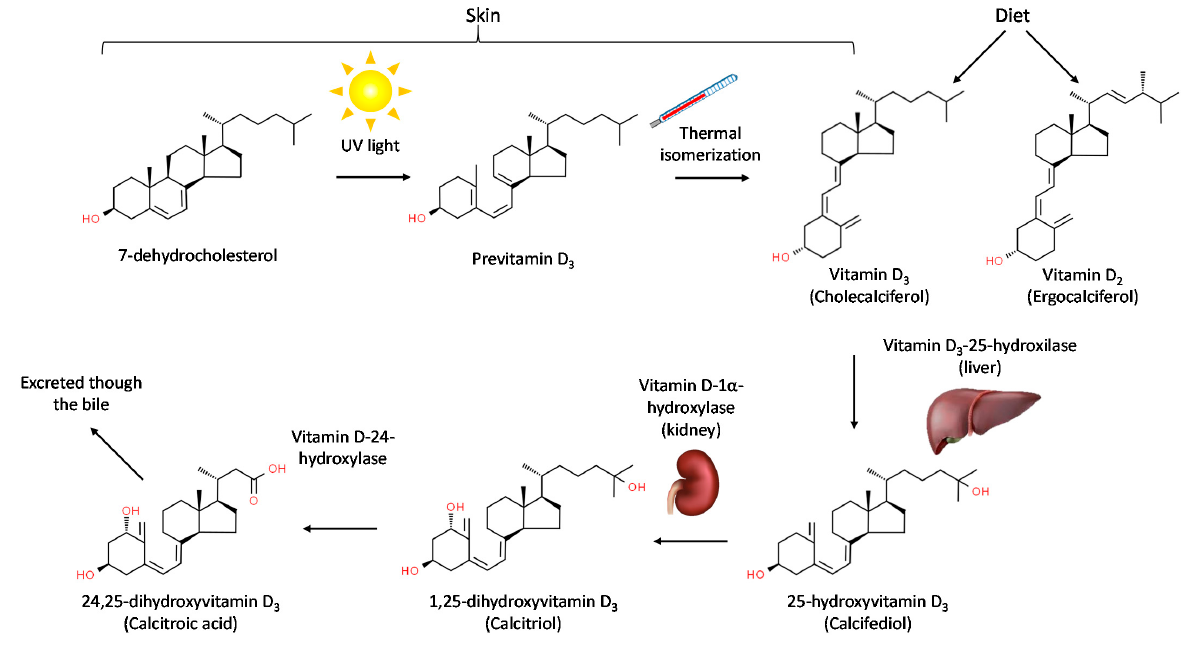
Figure 1. Metabolism of vitamin D. Vitamin D exerts its function mainly through binding to the vitamin D receptor (VDR), which belongs to the family of steroid nuclear receptors [15]. The VDR dimerizes with the retinoid X receptor (RXR) upon the vitamin D binding [16,17] and binds to DNA in the so-called vitamin D response element (VDRE) [18]. Interestingly, the VDR also has vitamin-D-independent actions [19]. This is the case of the roles of the VDR in hair follicle cycling [20] and in skin cancer development